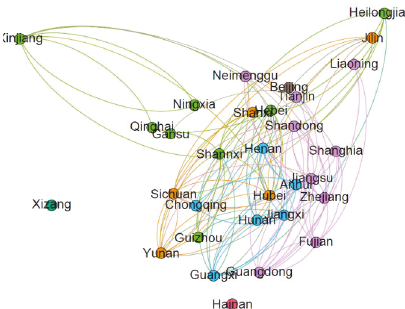
Figure 9: The network of coupling three layers and the